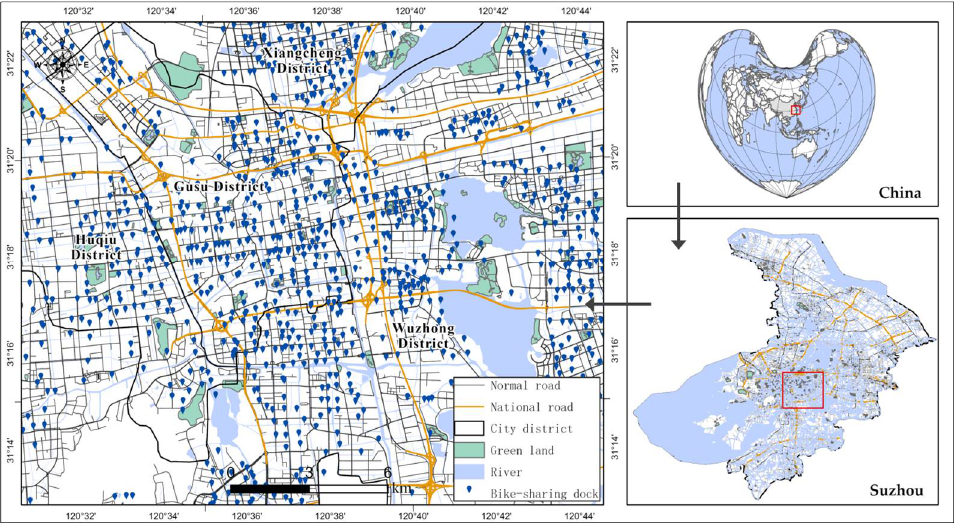
Figure 2. Study area (city center of Suzhou, China).